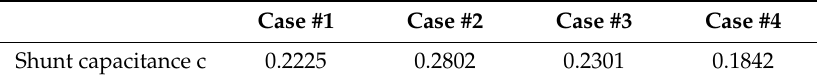
Table 9. Capacitances in p.u.l. of the four cases in µ F / km with IEC.